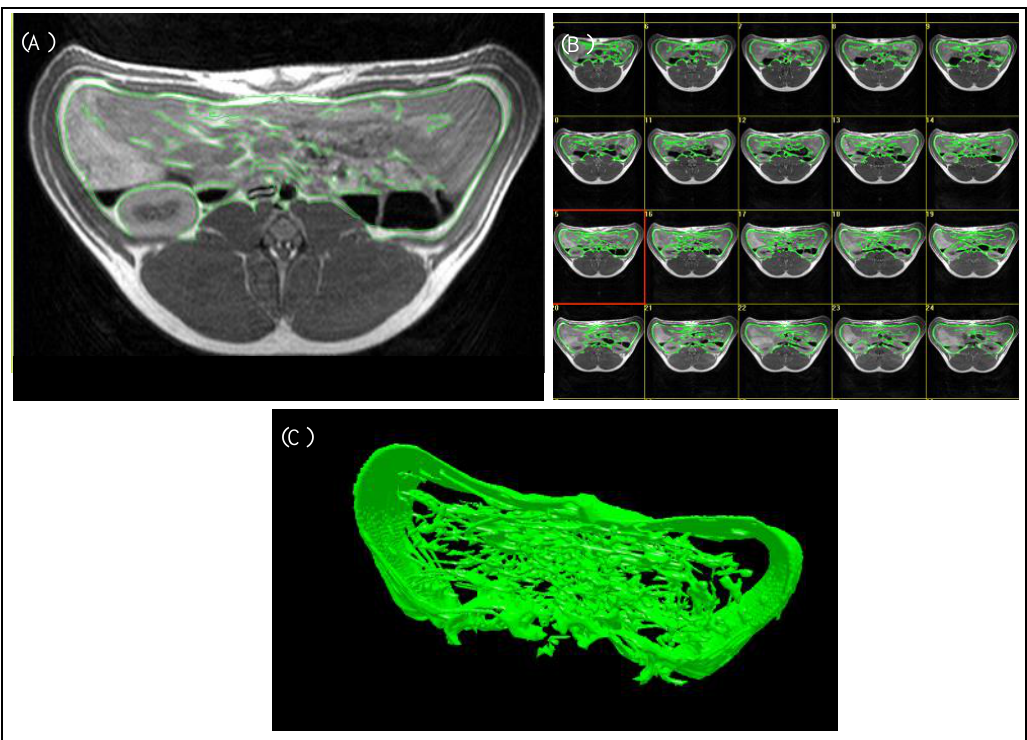
Figure 3. Evaluation of MR images using the Able 3D-Doctor ® software. ( A ) T1-weighted axial MR image with green boundaries, including the visceral adipose tissue. ( B ) Analysis of all slices in the defined body region. ( C ) Reconstruction of a 3D-model from the selected boundaries of VAT.